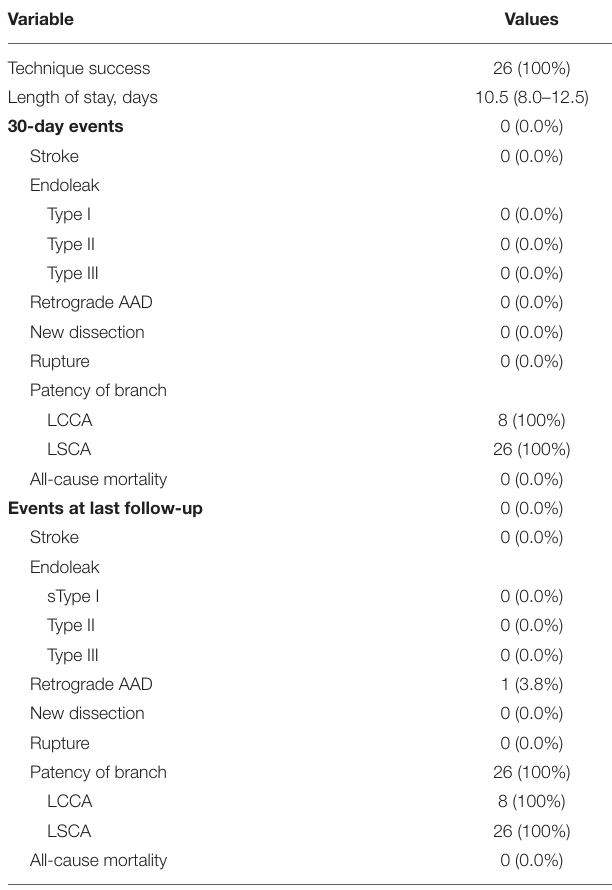
TABLE 1 | Baseline characteristics of patients receiving the MCPF technique.